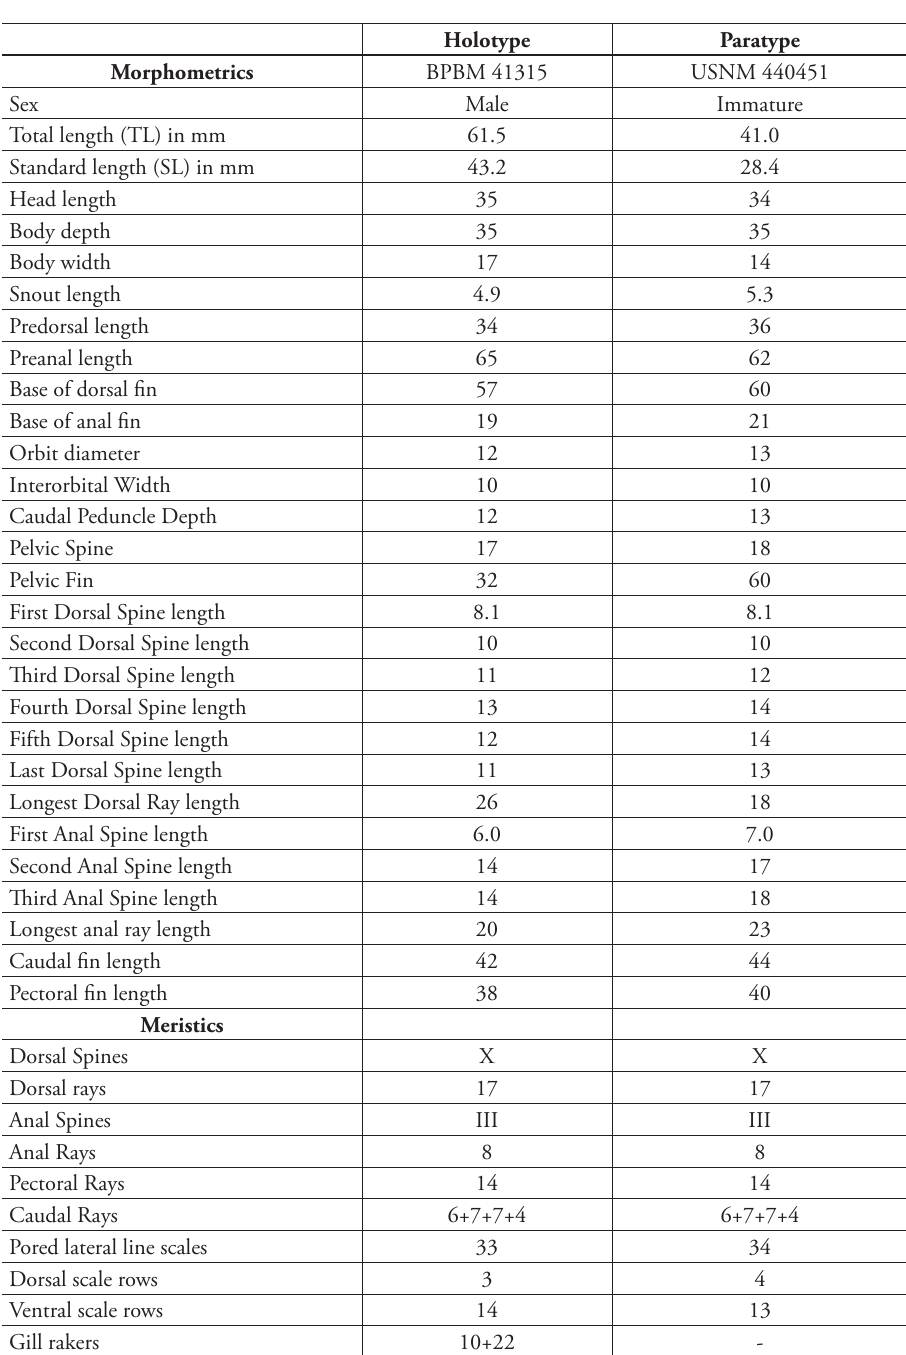
Table 1. Morphometric and meristic data for selected characters of type specimens of Tosanoides obama . Values of morphometric data (other than TL and SL) are represented as % of